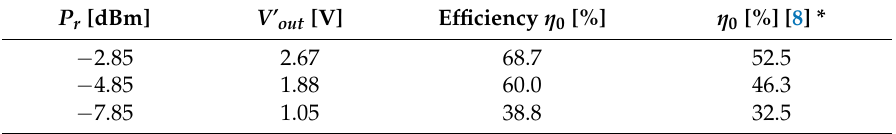
* At 940 MHz. Estimated from Figure 7 in [8].